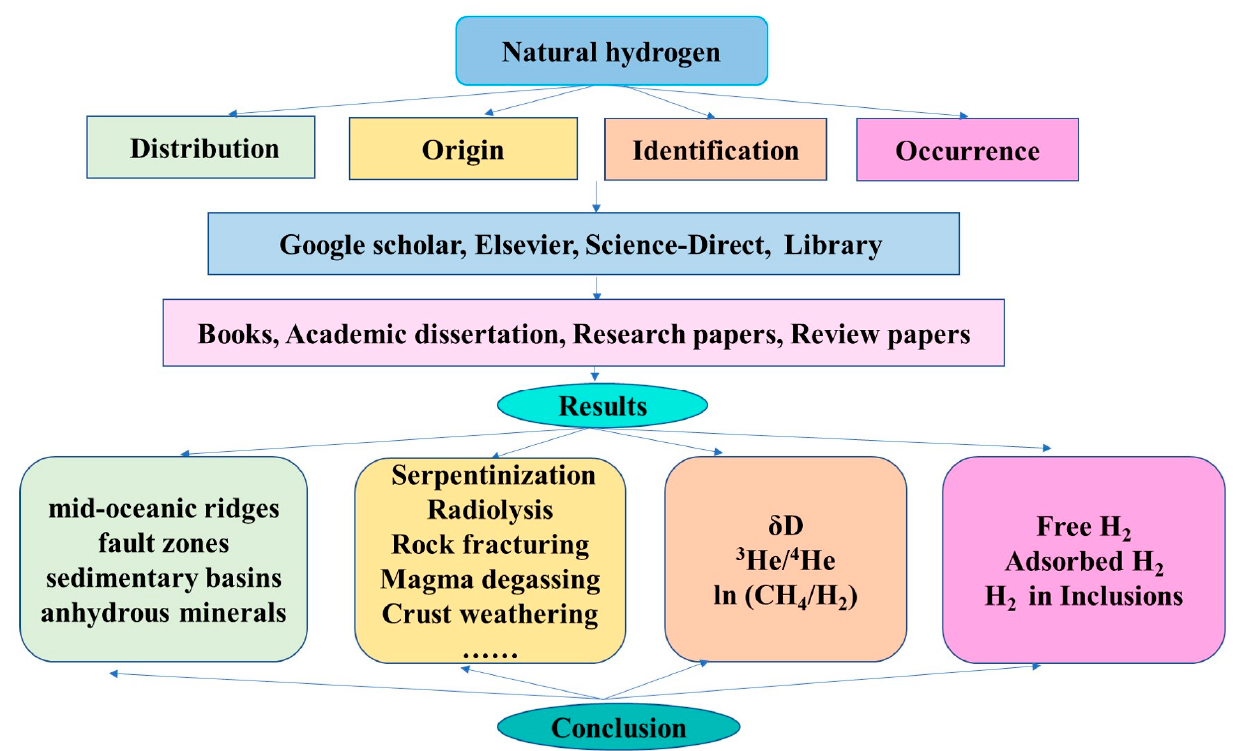
Figure 2. Scheme of the research method.